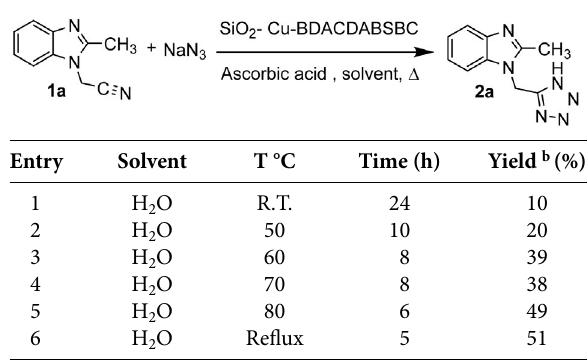
Table 2. Effect of solvent type and temperature on [3+2] cycloaddi- tion reaction of azide-nitrile using Cu-BDACDABSBC and ascorbic acid to afford 2a a